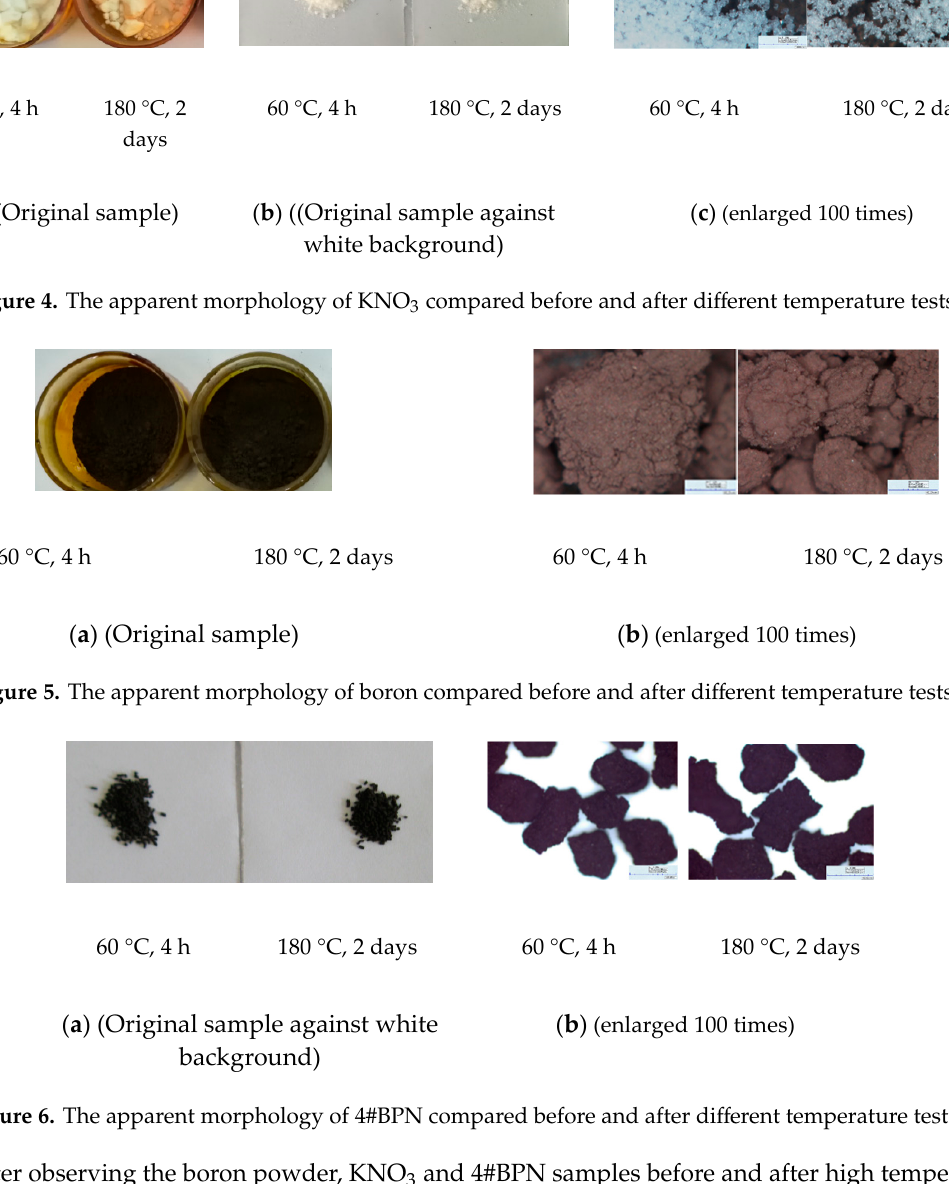
Figure 6. The apparent morphology of 4#BPN compared before and after different temperature tests.